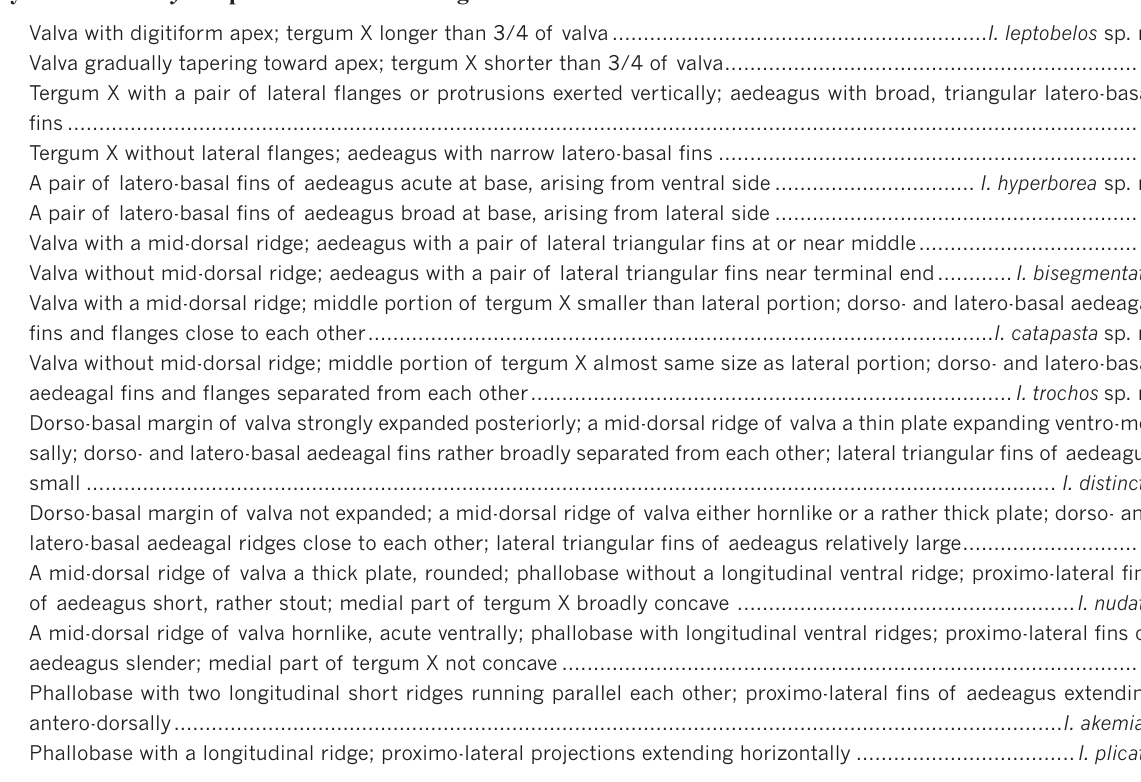
(Fig. 19:10); 1♀ emerged on 9.VII.2015 collected by MK on 28.VI.2015 at Okutadami dam, Uonuma-shi, Niigata Pref (Fig. 19:18); 1 larva collected by N. Yo- shikawa on 9.XII.2013 at Tadami-cho, Fukushima Pref